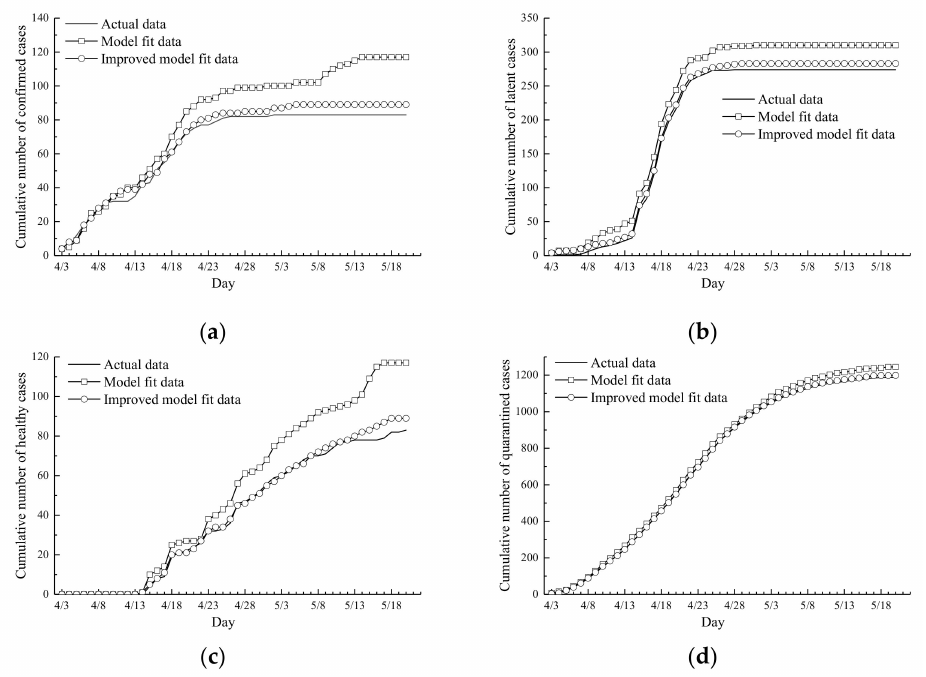
Figure 4. Model fitting results: ( a ) cumulative confirmatory fitting results; ( b ) cumulative latent population fitting results; ( c ) cumulative number of cures fitting results; ( d ) cumulative isolation number fitting